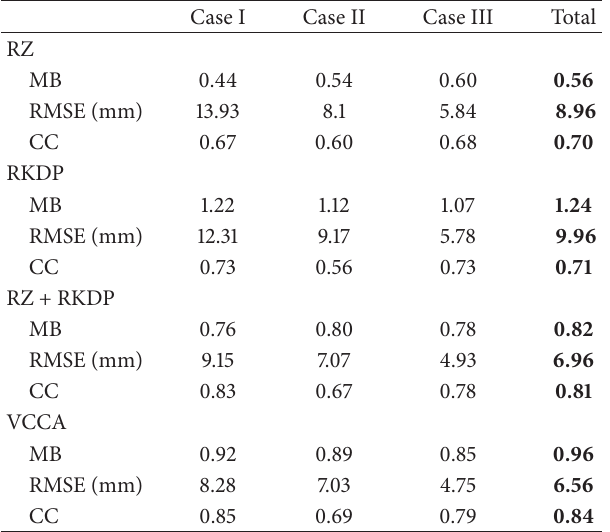
Table 2: The statistical scores of mean bias (MB), root mean square Table 3: Similar to Table 2, only those QPE-gauge pairs in which error (RMSE), and correlation coefficient (CC) obtained from two the gauge’s heights are 500 m or higher above sea level are used in typhoons (72-hour data), one mei-yu (48 hours data), and long- the statistical term stratiform precipitation (120-hour data). The results from ) only, four approaches are included; they are 𝑅(𝑍) only, 𝑅(𝐾 DP ) and 𝑅(𝑍) without vertical correction (CA), combination of 𝑅(𝐾 DP and the vertically corrected composite algorithm (VCCA).